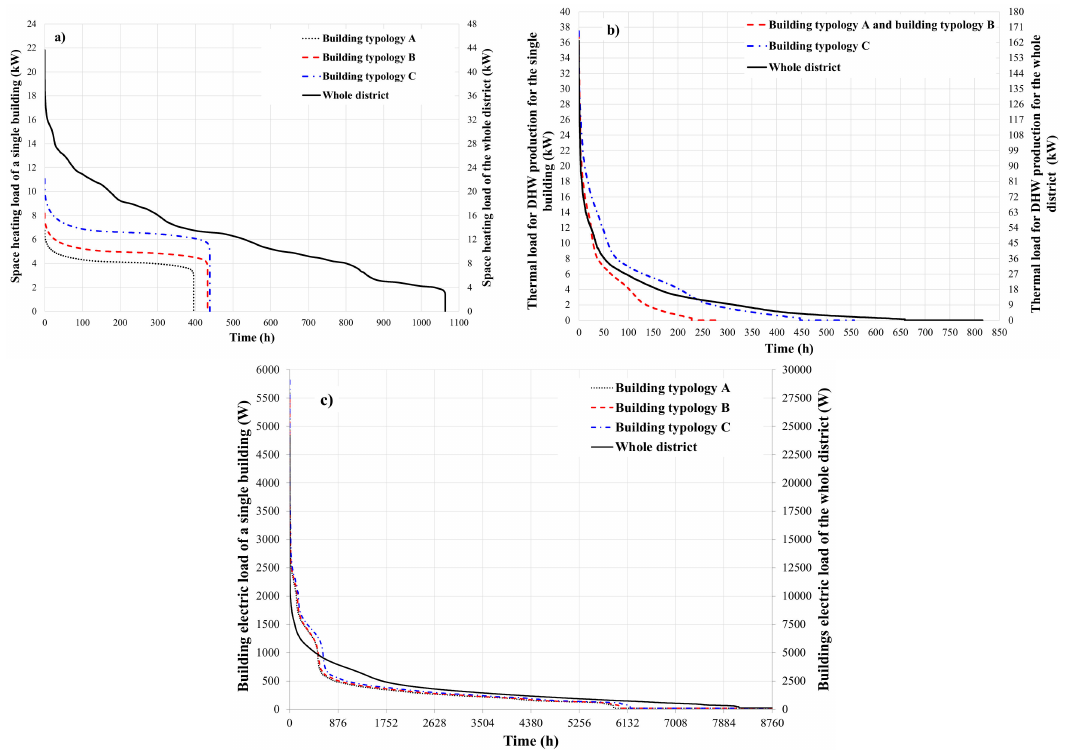
Figure 1. Load-duration diagrams for space heating ( a ), DHW production ( b ) and electric demand ( c ) associated to each single building as well as all